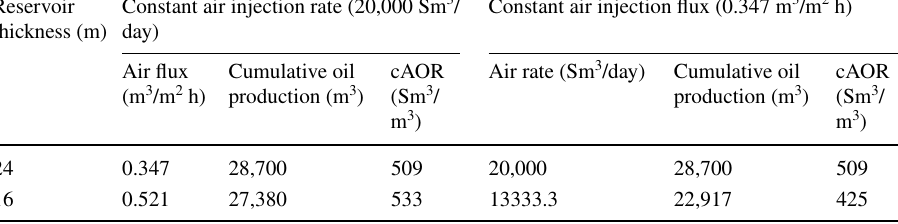
Table 7 Results comparison for the constant air injection rate versus constant air injection flux after 2 years of